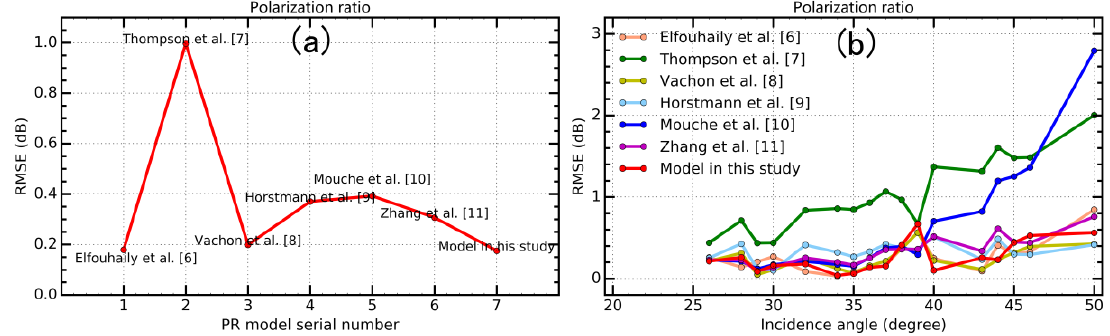
Figure 16. The RMSE of PR models compared to GF-3 PR measurements. ( a ) Each RMSE is from full data; and ( b ) each RMSE is from an incidence angle bin of 1 ◦